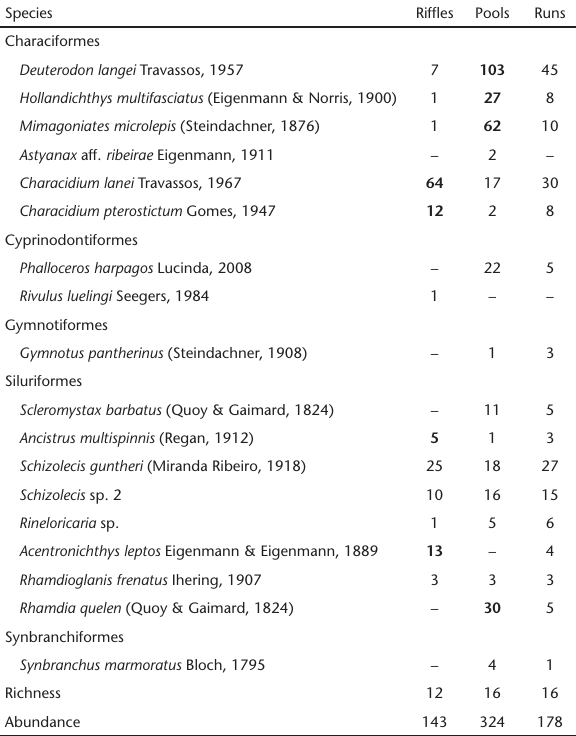
in riffle, pool and run mesohabitats of middle reach in the Vermelho River, Paraná state, Brazil. In bold, predominant species.